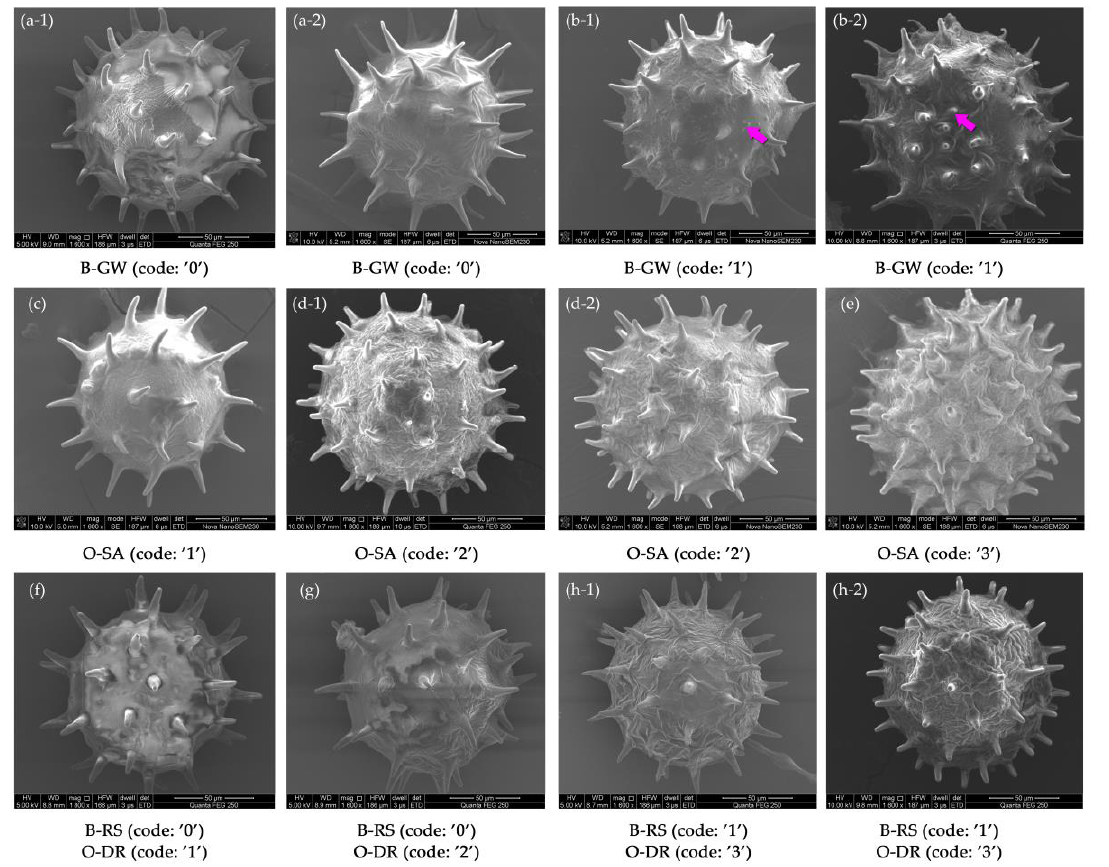
Figure 4. The description and codes for four qualitative traits of Hibiscus syriacus pollen grains, where the red arrow indicates the typical characteristic. Whether the pollen surface has granular verrucae (B-GW): ( a - 1 , a - 2 ) pollen exine is smooth or ruffled without micro-spines or granular verrucae (No, 0); ( b - 1 , b - 2 ) pollen exine has micro-spines or granular verrucae (Yes, 0). Number of pollen surface spines (O-SA): ( c ) pollen surface spines less than forty in number (<40, 1); ( d - 1 , d - 2 ) pollen surface spines varying between forty and fifty (40~50, 2); ( e ) pollen surface spines greater than or equal to fifty in number ( ≥ 50, 3). Whether the pollen surface ruffles strongly (B-RS): ( f , g ) pollen surface not strongly ruffled, smooth, or slightly ruffled (pollen surface ornamentation is inconspicuous or with a small number of ornaments) (No, 0); ( h - 1 , h - 2 ) pollen surface strongly ruffled (pollen surface with distinctive ornamentation) (Yes, 1). Degree of pollen surface ruffling (O-DR): ( f ) pollen surface smooth and free of ruffles (pollen surface ornamentation is inconspicuous) (smooth and largely unruffled, 1); ( g ) pollen surface is slightly ruffled (pollen surface with a small number of ornaments) (light ruffles, 2); ( h - 1 , h - 2 ) pollen surface strongly ruffled with striate or a mixture of striate and cerebroid (pollen surface with distinctive ornamentation) (strong ruffles,